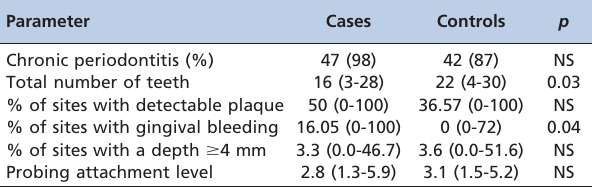
Table 2 - Oral health parameters in breast cancer survivors and